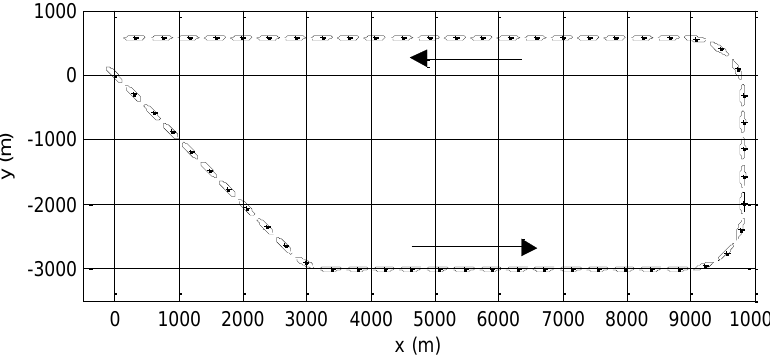
Figure 5. Target trajectory of simulation scenario 2.